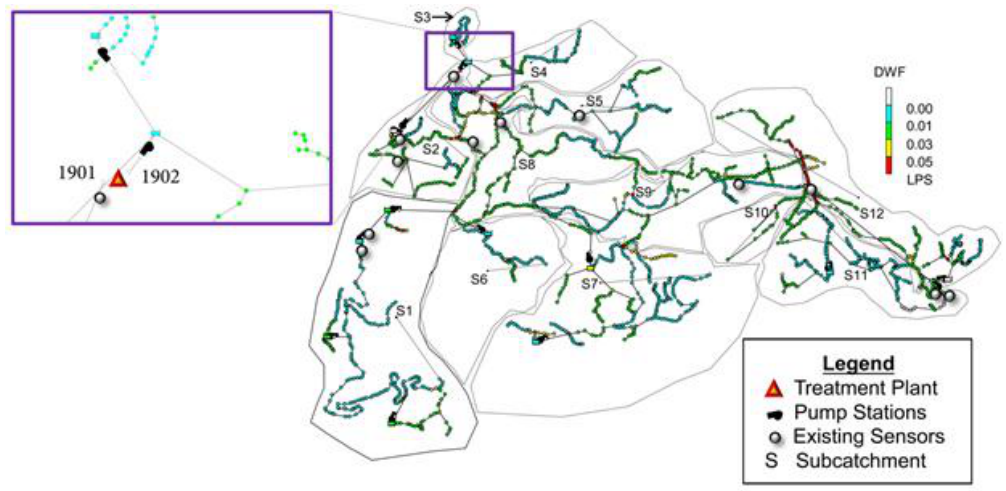
Figure 1. Scheme of the Massa Lubrense system.